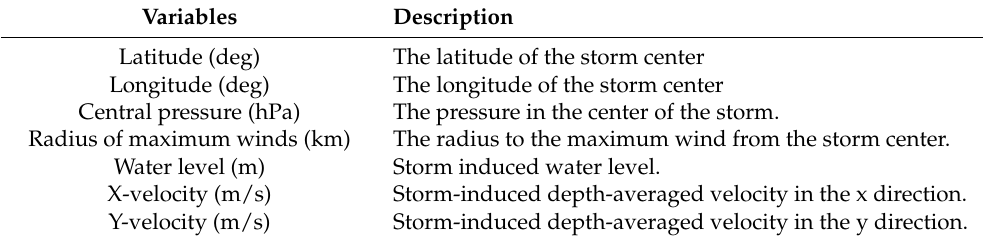
Figure 1. The synthetic storm tracks used by the NACCS storm surge dataset. In total, 1031 storm tracks were randomly divided into two groups: ( a ) The first group of 981 storms was used to train the neural network storm surge forecast model, and ( b ) the second group of 50 storms was used to test the trained model. Three save points where storm surge forecast models developed in this work are indicated in a diamond marker. The red dashed line in subplot ( a ) indicates a training storm analyzed in Figures 3 and 4. Table 2. The definitions of parameters used for storm surge forecast model